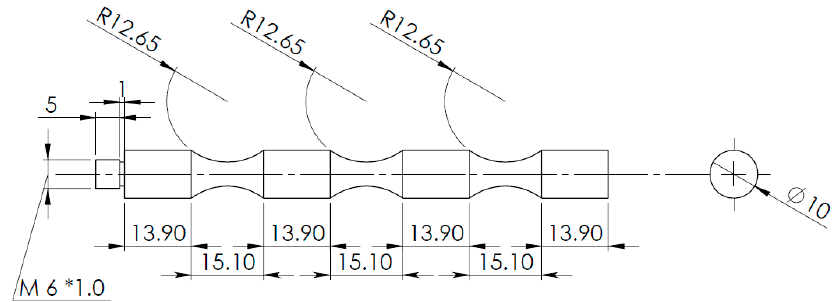
/ torsion specimen for VHCF Figure 15. Tension/torsion specimen for VHCF [2,15]. Figure 15. Tension